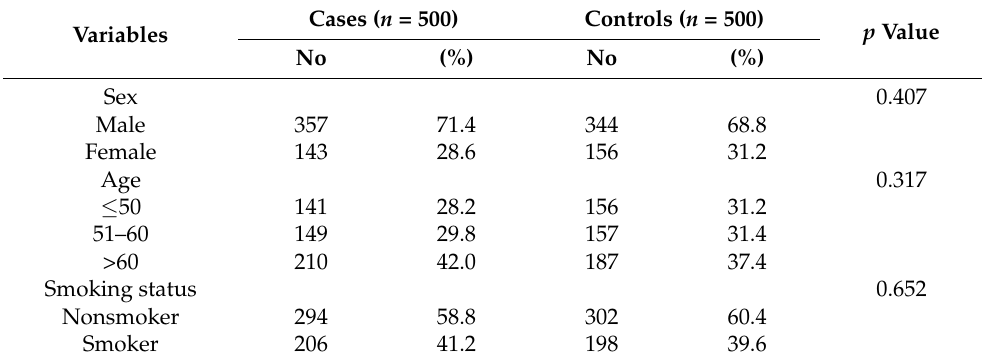
Table 1. Distribution of selected characteristics in cases and